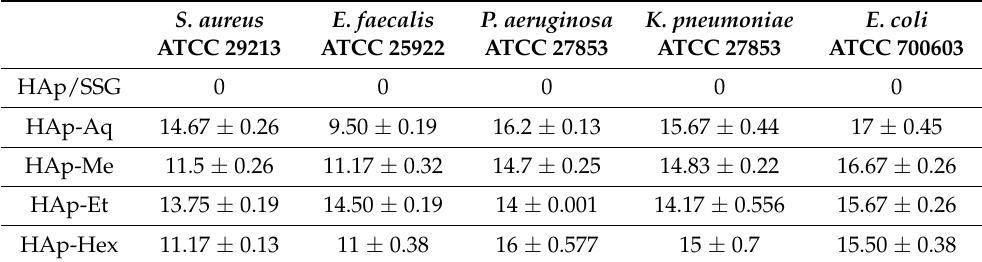
Figure 4. Statistical histogram of the pore size distribution derived from the SEM micrographs. Table 1. Inhibition zone diameters of NS -loaded